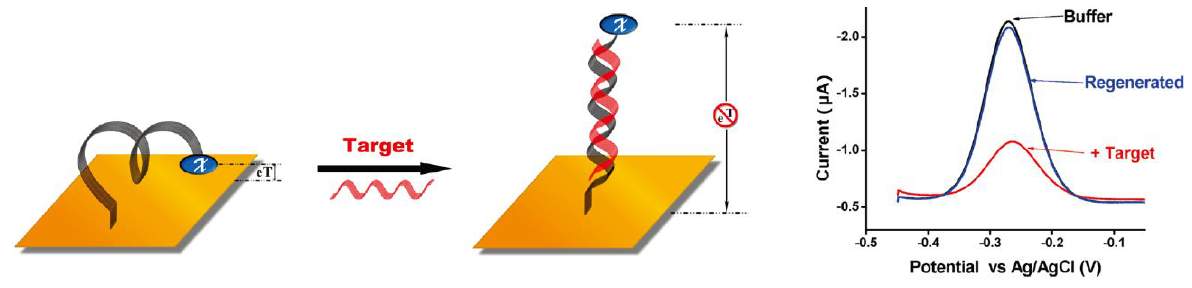
Figure 2. Fc-tagged DNA biosensor detecting hybridization. Reprinted with permission from White et al . [9]. Copyright 2009 American Chemical